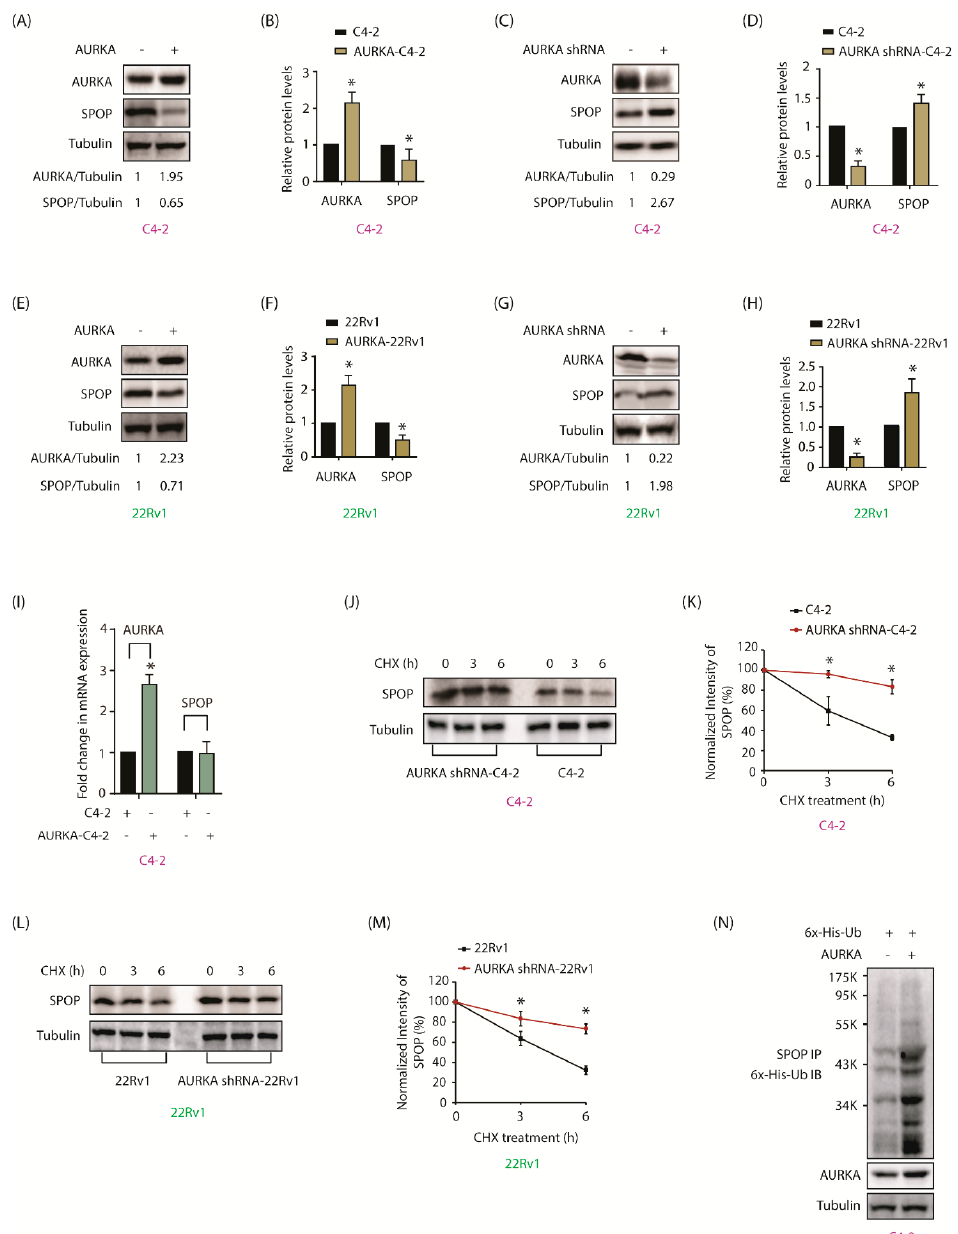
Figure 2. AURKA negatively regulates SPOP by degrading it in CRPC cells. ( A ) AURKA negatively regulates SPOP in C4-2 cells. ( B ) Histogram showing change in SPOP levels with AURKA overexpression. The data are presented as mean ± SEM obtained from three independent experiments. * p < 0.05 vs. C4-2 control cells. ( C ) AURKA silencing increases SPOP levels in C4-2 cells. C4-2 cells were infected with either scrambled shRNA lentivirus or AURKA shRNA lentivirus, followed by IB. ( D ) Histogram shows change in SPOP levels with AURKA knockdown. The data are presented as mean ± SEM obtained from three independent experiments. * p < 0.05 vs. C4-2 control cells. ( E ) Overexpression of AURKA decreased the levels of SPOP protein in 22Rv1 cells. ( F ) Histogram shows change in SPOP levels with AURKA overexpression. ( G ) AURKA silencing increases SPOP protein